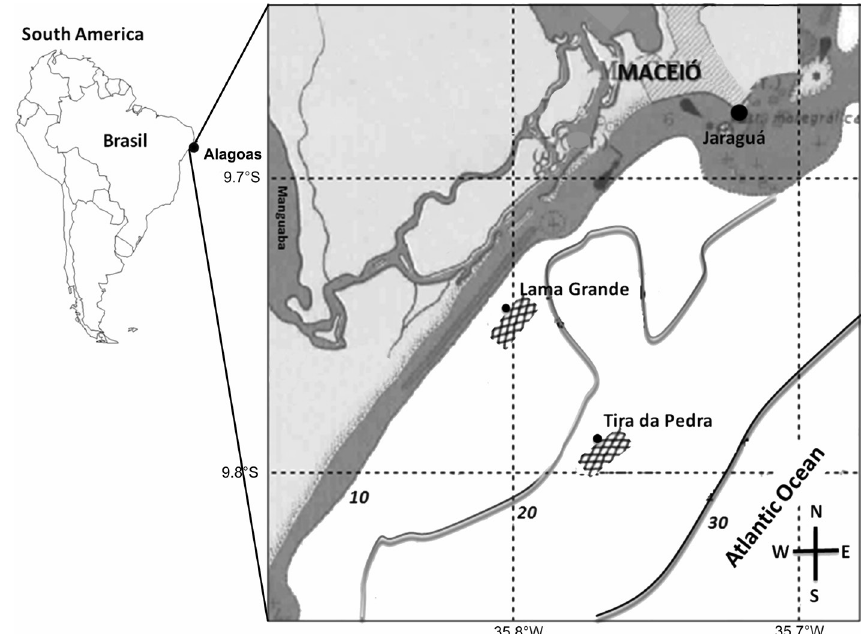
Figure 1. Location of the sampled area within the Alagoas coast. Jaraguá fishing harbor and the fishery sites were